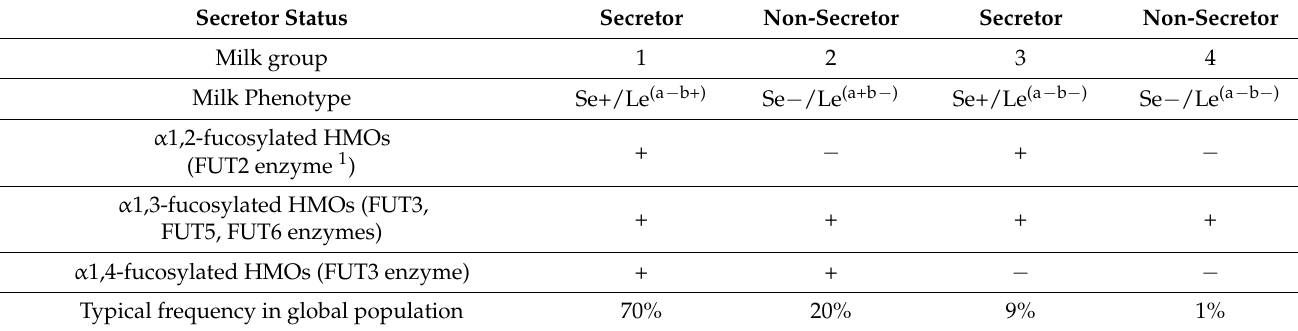
Table 2. Distribution of mothers’ phenotypes and corresponding milk